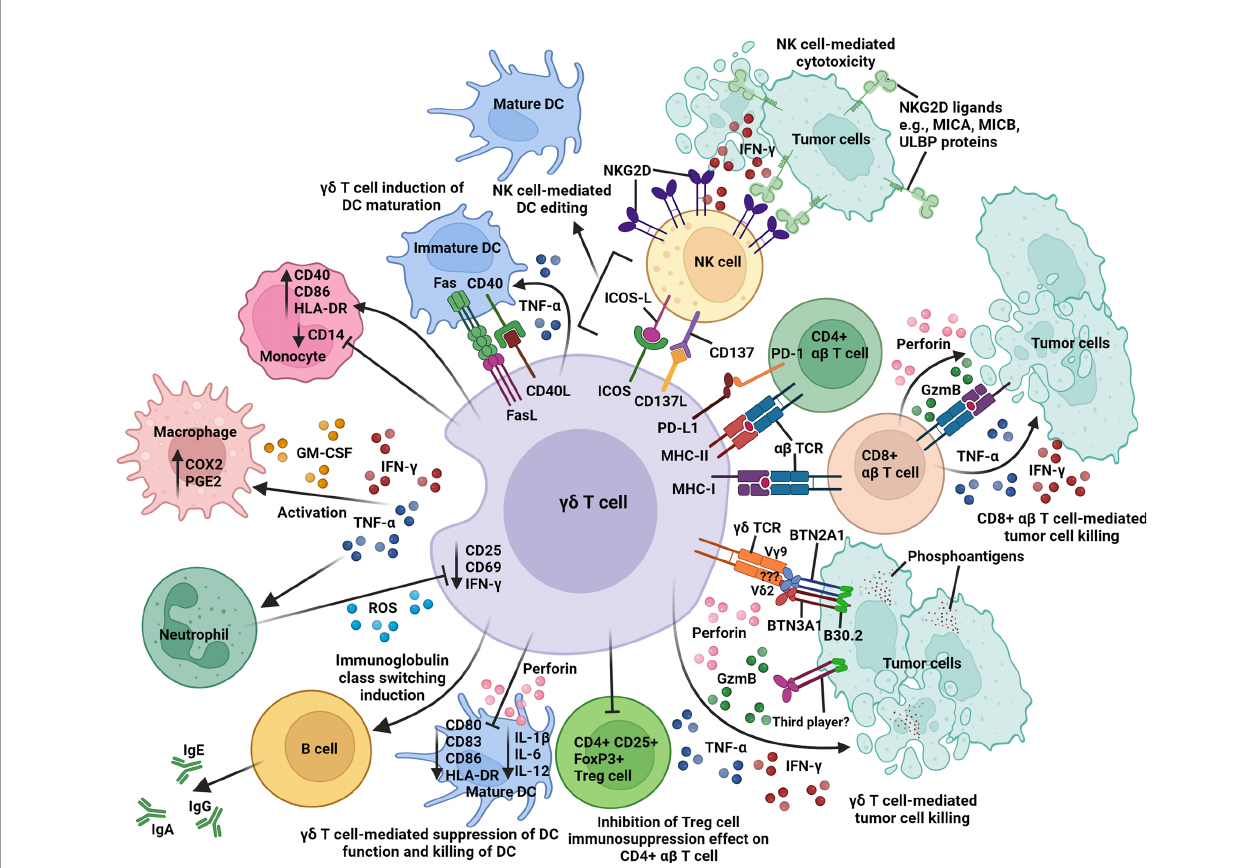
FIGURE 2 | An overview of the intricate network of immune interactions between gd T cell and other immune cells in the tumor microenvironment. Activated gd T cells express different surface receptors and molecules ( gd TCR, ICOS, MHC class I and II), ligands (CD40L, CD137L, FasL, and PD-L1), cytokines (IFN- g and TNF- a ), and GM-CSF for contact-dependent and independent crosstalk with tumor cells, CD4 + and CD8 + ab T cells, NK cells, DCs, macrophages, and neutrophils. Activated gd T cells cross-present antigens to CD4 + and CD8 + ab T cells; induce B-cell immunoglobulin class switching; co-stimulate NK cells via CD137/CD137L and ICOS/ICOS-L interactions; induce upregulation of CD40, CD86, and HLA-DR expression on monocyte; promote DC maturation via CD40/CD40L and Fas/FasL interactions; and inhibit the immunosuppression function of CD4 + CD25 + FoxP3 + Treg cells on CD4 + ab T-cell activity. In contrast, activated gd T cells can also suppress DC function (downregulation of CD80, CD83, CD86, HLA-DR, IL-1 b , IL-6, and IL-12) and mediate DC killing via perforin release. Butyrophilin 2A1 and 3A1 (BTN2A1 and BTN3A1); cyclooxygenase-2 (COX2); granulocyte-macrophage colony stimulating factor (GM-CSF); granzyme B (GzmB); human leukocyte antigen-DR (HLA-DR); immunoglobulin A, E, or G (IgA, IgE, or IgG); inducible T-cell co-stimulator (ICOS); ICOS ligand (ICOS-L); interferon- g (IFN- g ); major histocompatibility complex class I and II (MHC-I and -II); MHC class I chain-related antigens A and B (MICA and MICB); natural killer group 2D (NKG2D); programmed cell death 1